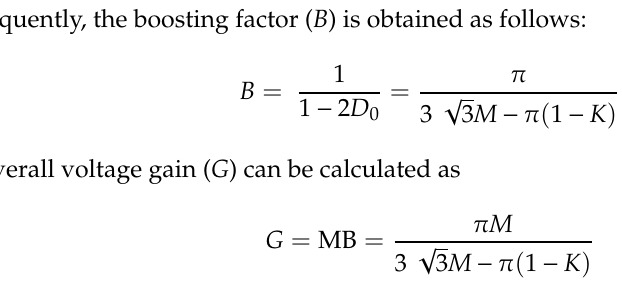
Figure 6. Proposed modified ZSI-DCPWM shoot-through duty ratio: ( a ) over one fundamental period at f = 50 Hz and K = 0.5, ( b ) Upper and lower envelopes during interval ( 𝜋